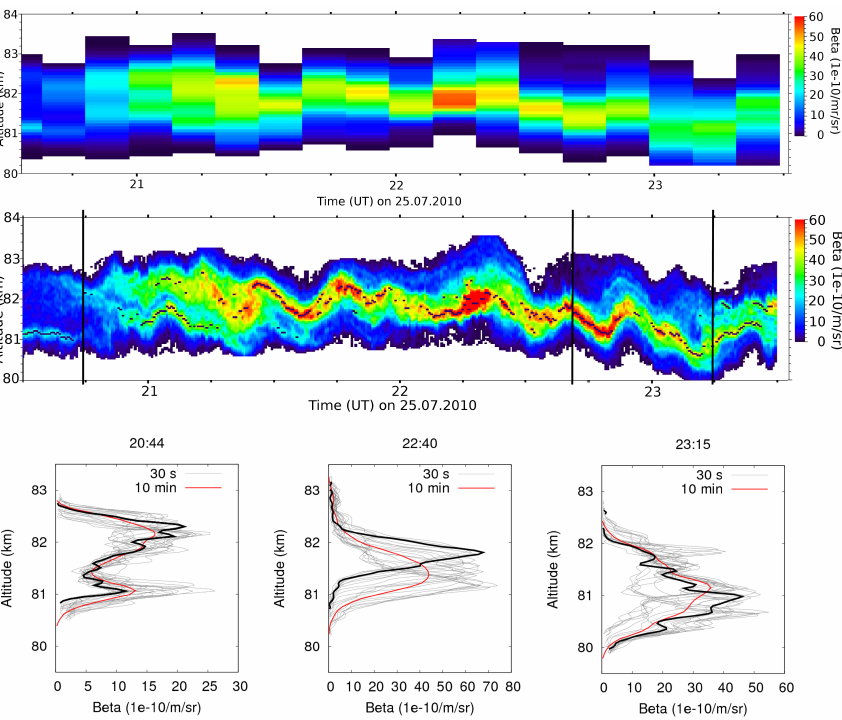
Fig. 2. Three hours of NLC observation on 25 July 2010, by the ALOMAR RMR lidar (SET) with 10min resolution (top) and with 30s resolution (middle). Detected layers are marked by black dots (threshold δβ = 12 × 10 − 10 m − 1 sr − 1 ; see text for details). Bottom: comparison of vertical profiles with 10min and 30s resolution at 20:44, 22:40 and 23:15UT, as marked in the high-resolution plot by vertical lines. The 30s profiles contributing to the 10min smoothed profile are shown in grey, the one at the exact time given in black. Note the different x axis